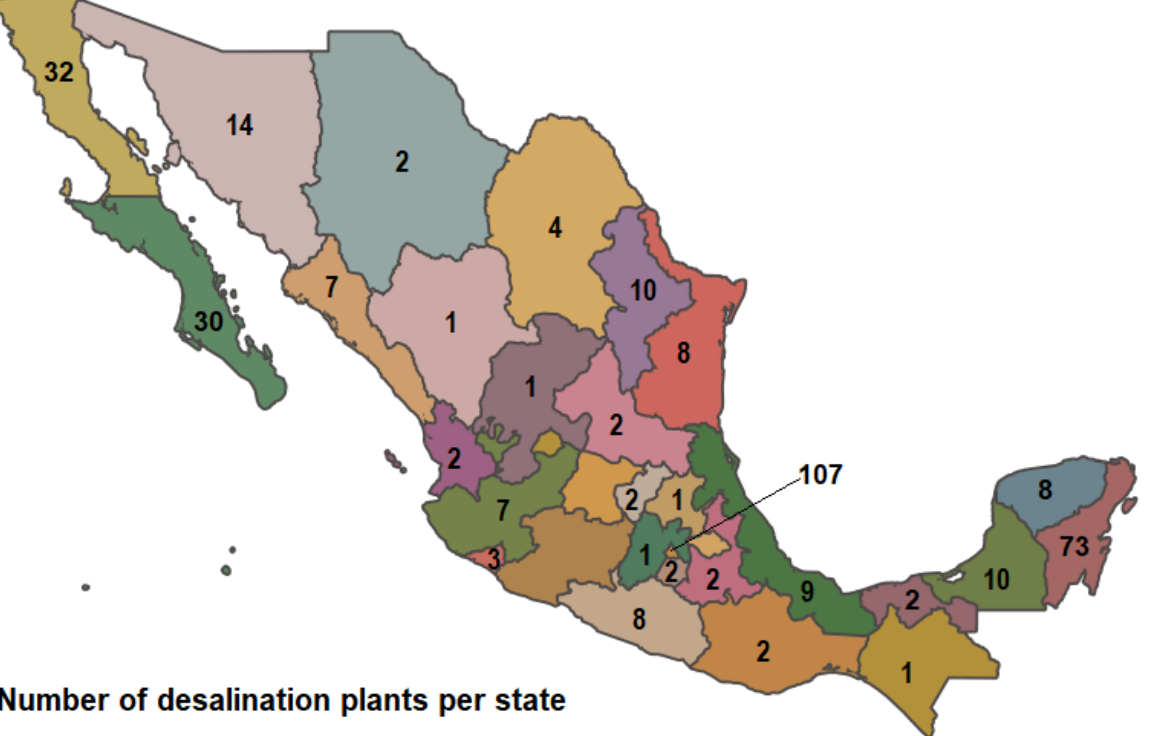
Figure 3. Number of desalination plants per state in Mexico, 2022.